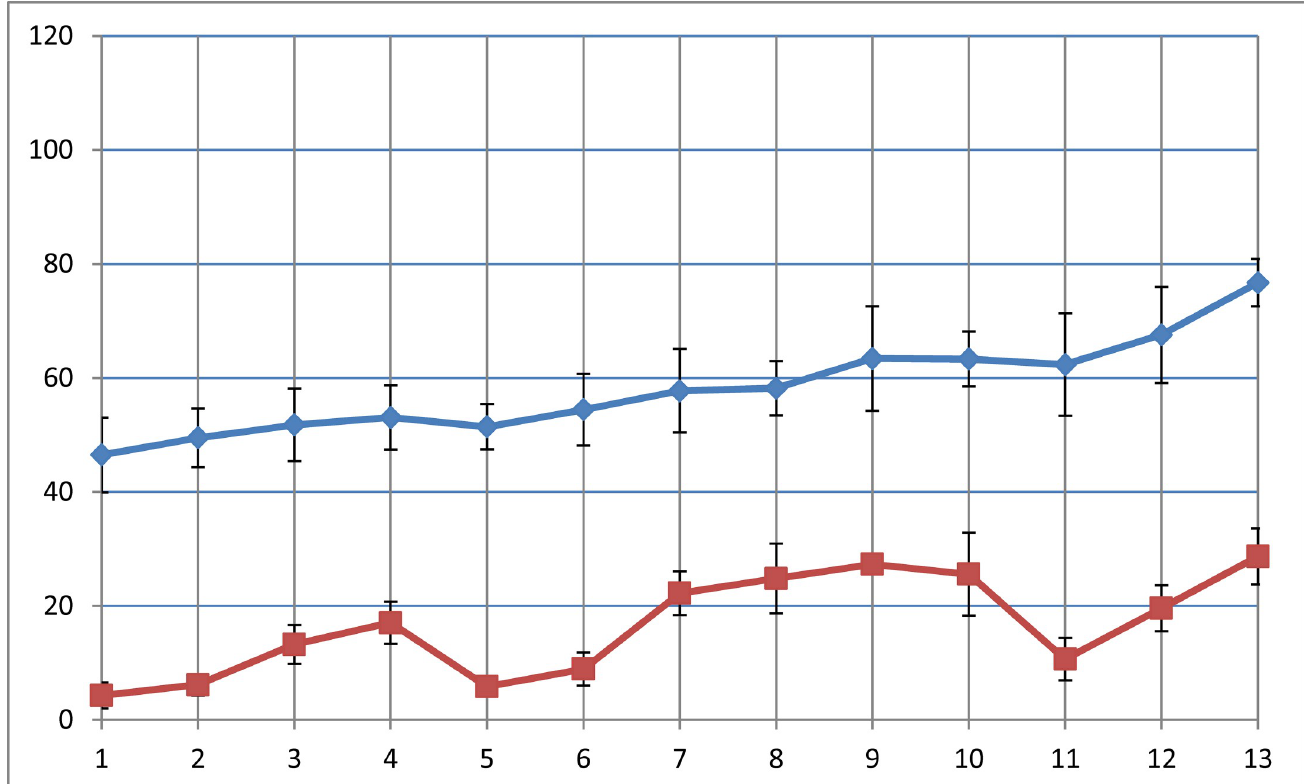
Fig 1. Associations between children’s and preschool staff’s average objectively measured MVPA during preschool.